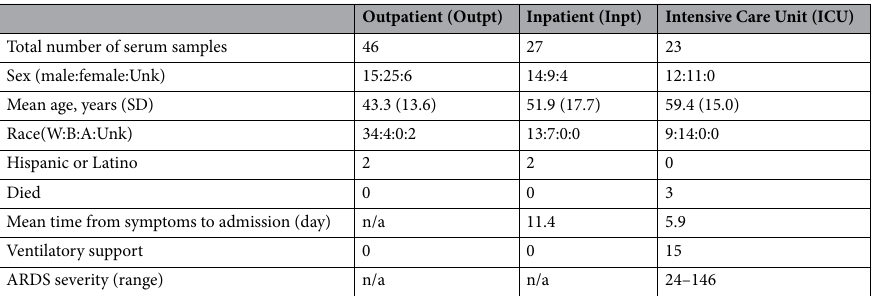
Table 3. Symptomatic COVID-19 serum samples from outpatients, inpatients, and patients in intensive care units. ARDS severity defined as PaO 2 /FiO 2 (only reported in 5 subjects). White (W), Caucasian/European; Black (B), African American/African; Asian (A); Unk (unknown); SD standard deviation, n/a not available, ARDS acute respiratory distress syndrome, PaO 2 oxygen in arterial blood, FiO 2 oxygen in the inspired air.